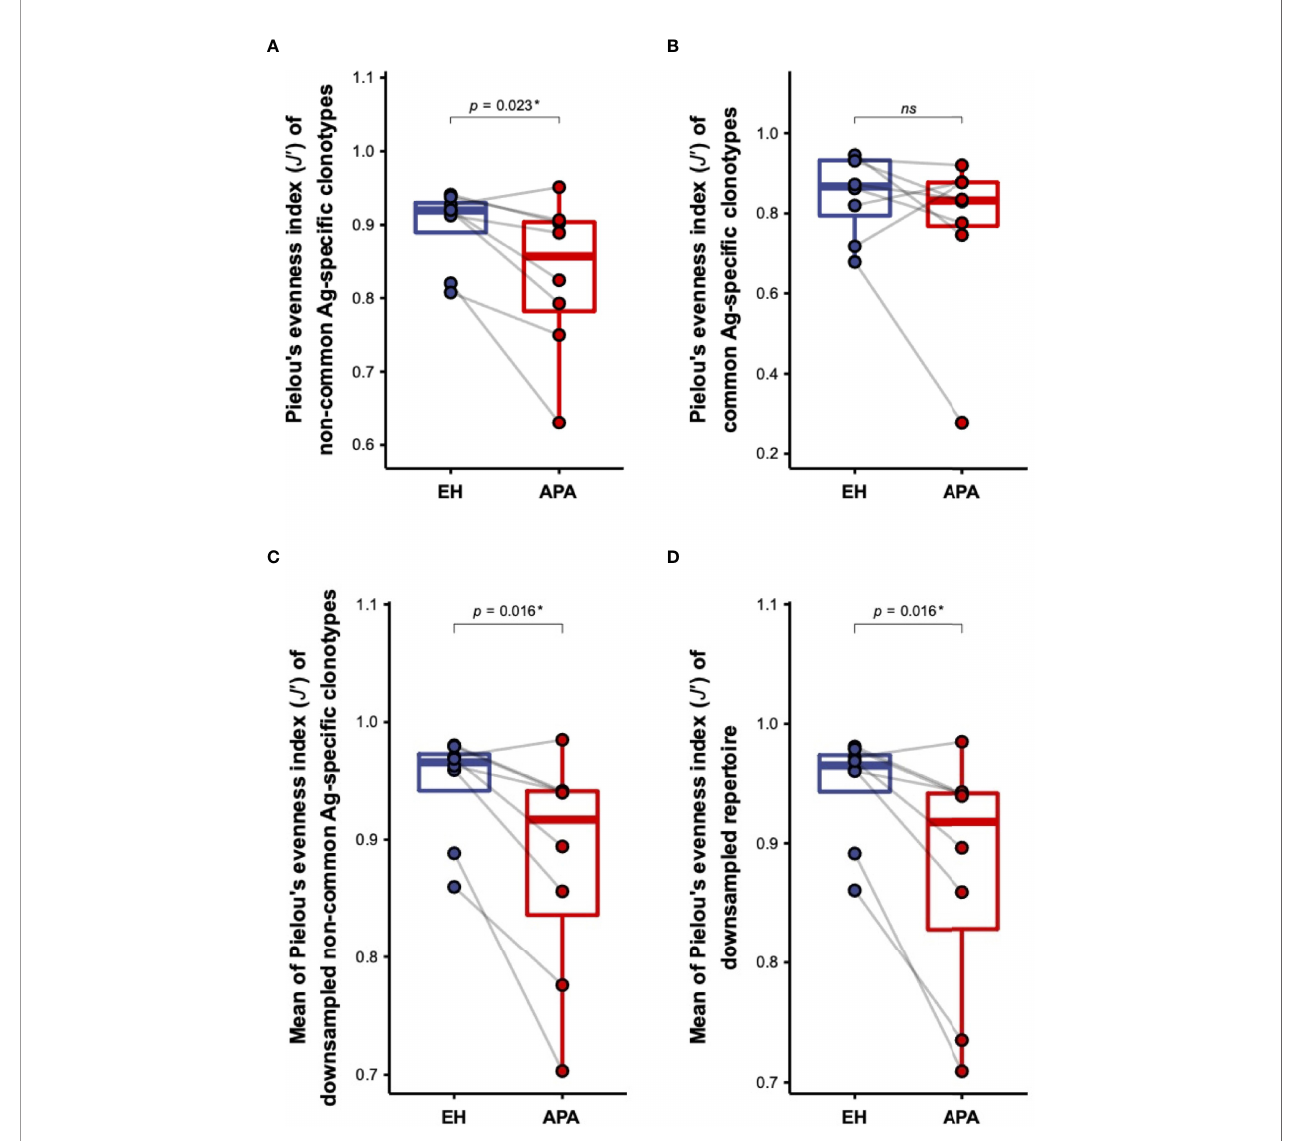
FIGURE 2 | The comparison of the diversity of TCR b clonotypes with distinct antigen speci fi cities between APA and EH patients. (A, B) The difference in repertoire diversity, estimated by the Pielou ’ s evenness index ( J ′ ), of non-common antigen-speci fi c (A) or common antigen-speci fi c (B) TCR b clonotypes was compared between APA and age-matched EH patients. (C, D) The comparison of the mean of diversities J ′ of 100 randomly subsampled TCR b repertoires from non-common antigen-speci fi c (C) or all (D) TCR b clonotypes between APA and age-matched EH patients was illustrated. The solid gray line denoted age-matched pairs and the two-sided p -values were shown from the Wilcoxon signed-rank test. The results of the comparison with corrected p -value >0.05 were considered to be not statistically signi fi cant and denoted by “ ns ” (not signi fi cant). p -value < 0.05 was considered to be statistically signi fi cant and marked with ‘ * ’